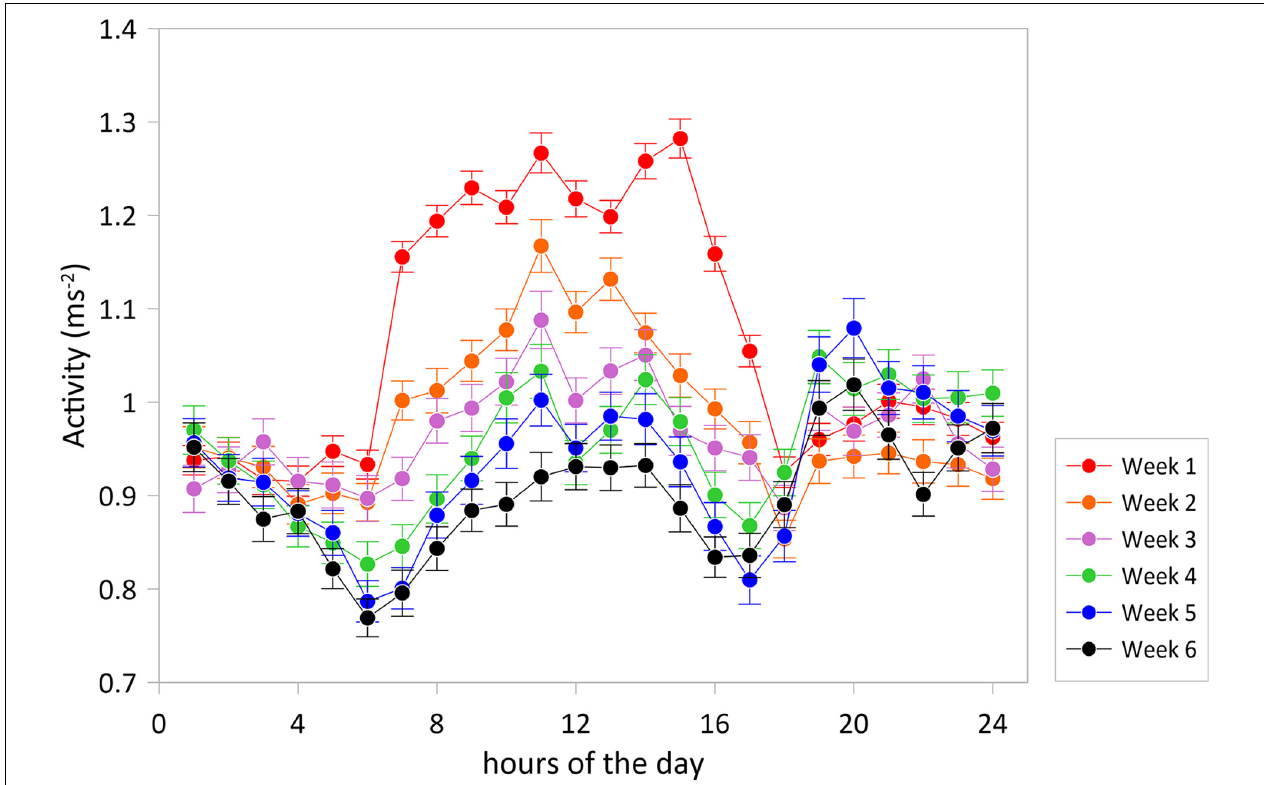
FIGURE 2 | Average accelerations ( ± SE) over the hours of the day for experimental weeks 1–6. The graph shows a typical W-shaped pattern with more active periods from 6 to 14 h and 18 to 0 h and less active periods from 0 to 6 h and 14 to 18 h and with diurnal accelerations decreasing toward the winter. The experimental period was started with N = 30 tagged fish, three fish were lost in action.